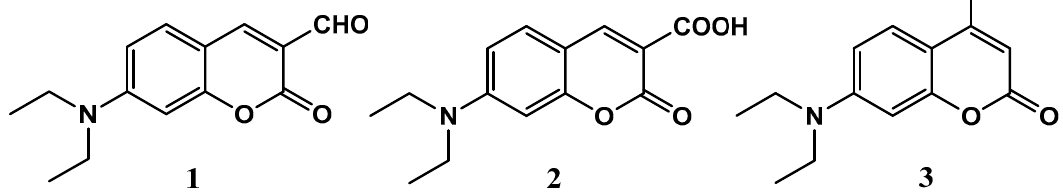
Figure 1. Structural formulae of fluorescent coumarins used for the in vitro detection of hypochlorite ions: ( 1 ) 7-diethylamino-3-formylcoumarin, ( 2 ) 7-diethylaminocoumarin-3-carboxylic acid, and ( 3 ) 7-diethylamino-4-methylcoumarin.